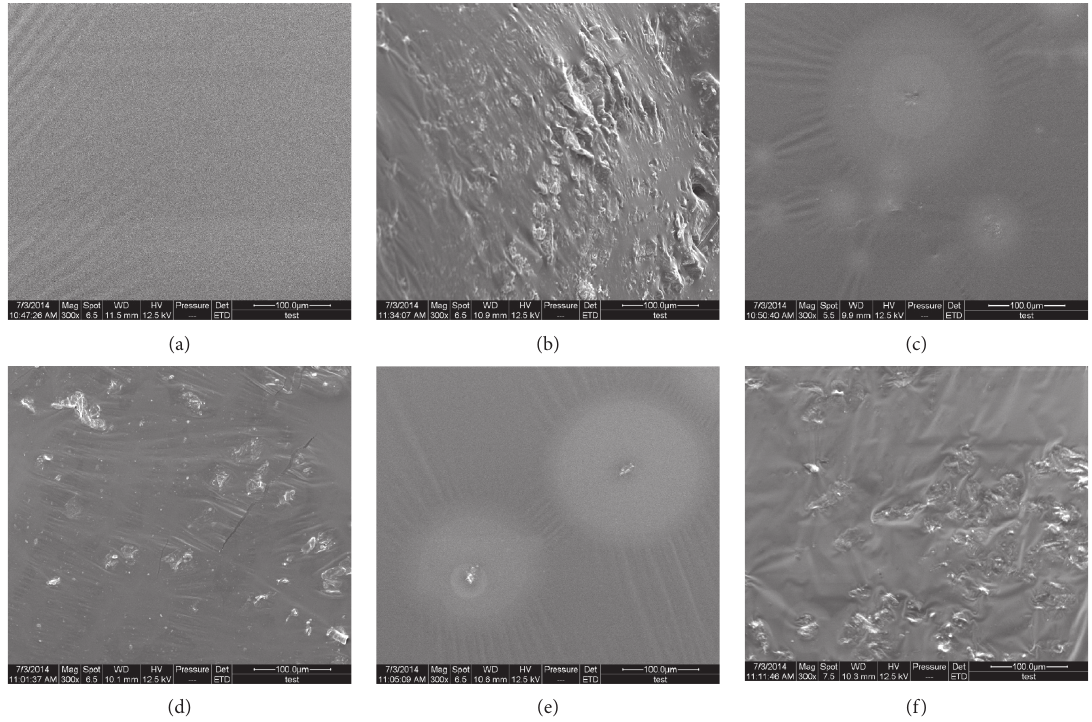
Figure 11: SEM photos of composite regenerating and modified asphalt. (a) 90# original asphalt. (b) SBS modified asphalt. (c) Aging asphalt (5h). (d) Aging asphalt (20h). (e) Regenerating asphalt (5h). (f) Regenerating asphalt (20h).